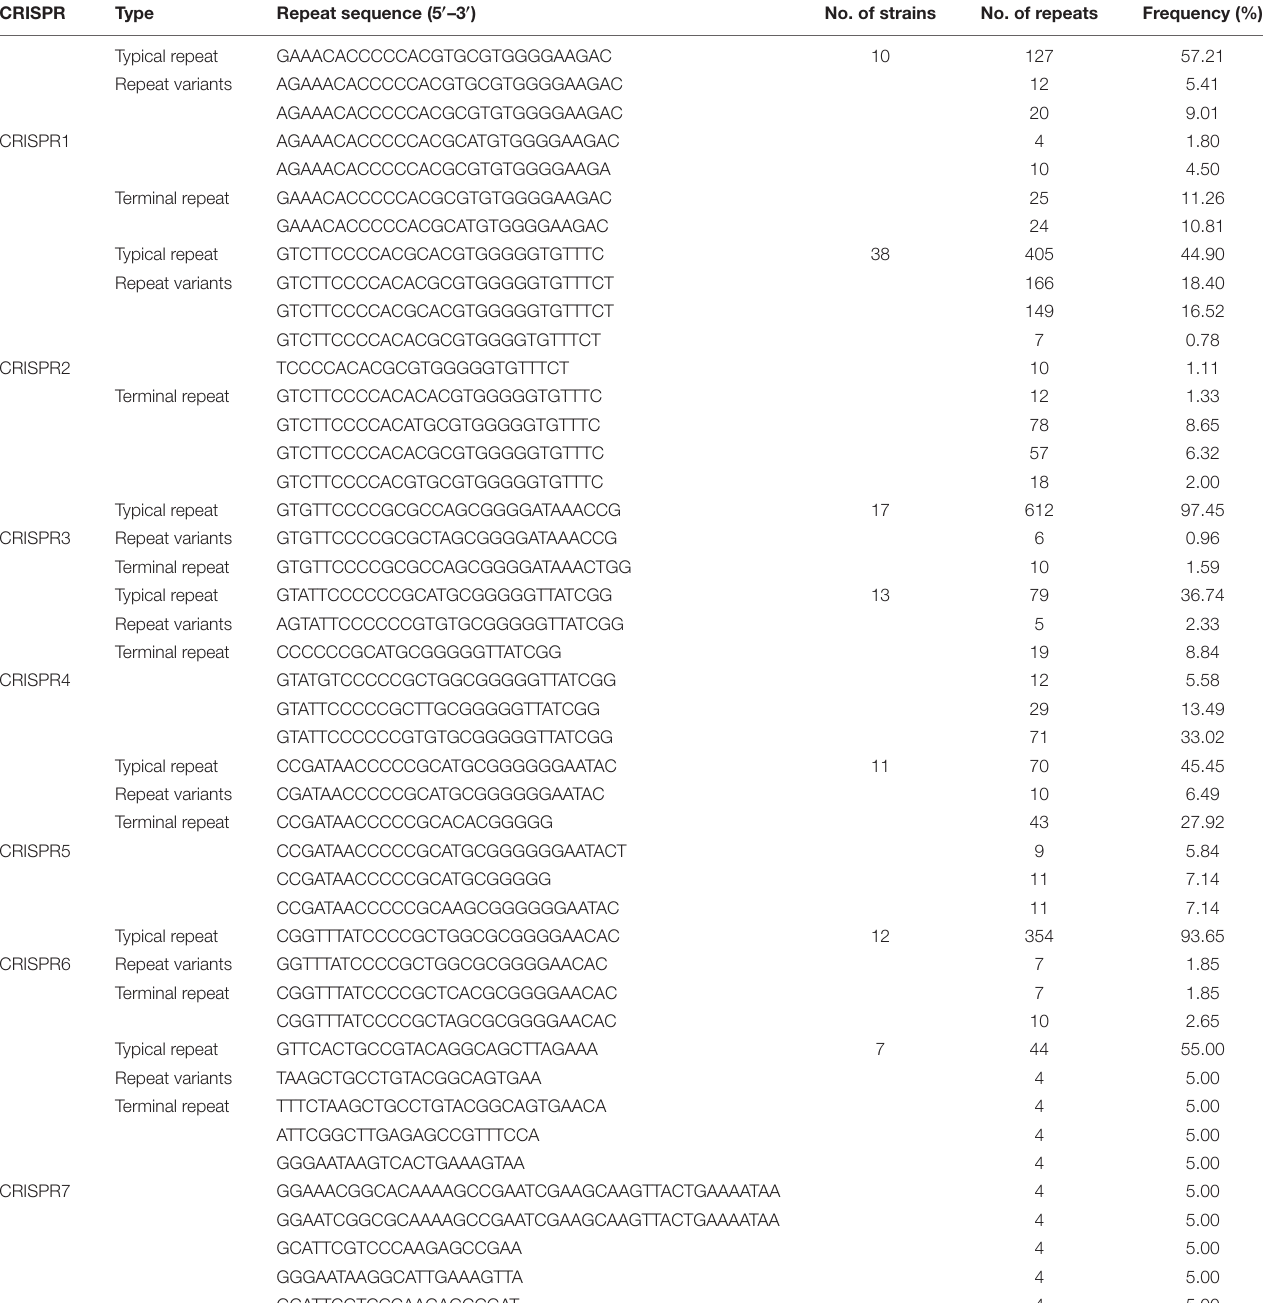
TABLE 1 | The information of the confirmed CRISPR1 ∼ CRISPR7